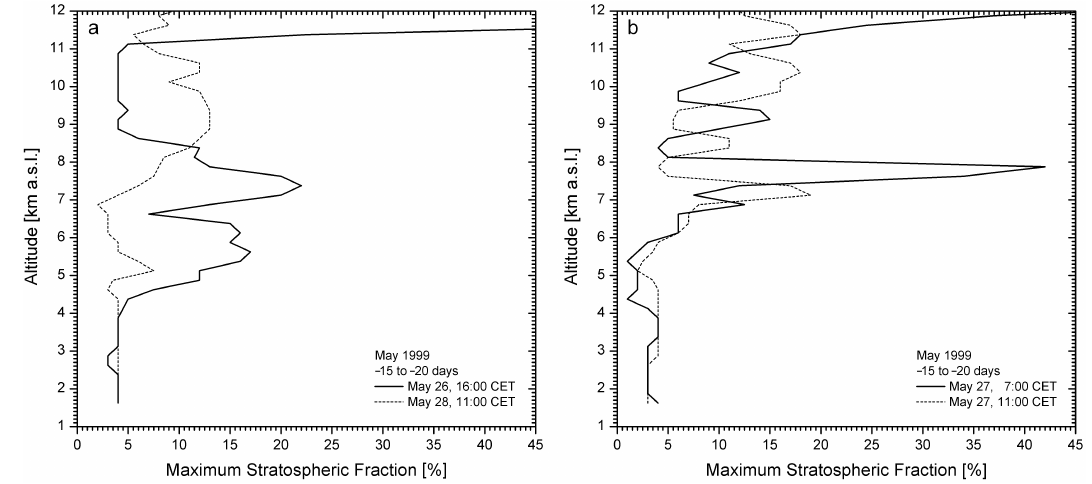
Fig. 10. Vertical distribution of the maximum stratospheric fraction in the twenty-day FLEXPART retroplumes calculated for the four measurements in Fig. 7, extracted from days − 20 to − 15: (a) 26 May and 28 May, (b) 27 May. 8 km, i.e., in the altitude range of the big aerosol peak in Fig. 8b and